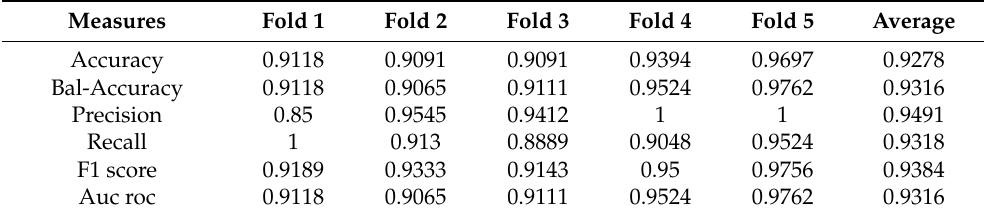
Table 2. K-folds performance results using DenseNet121.